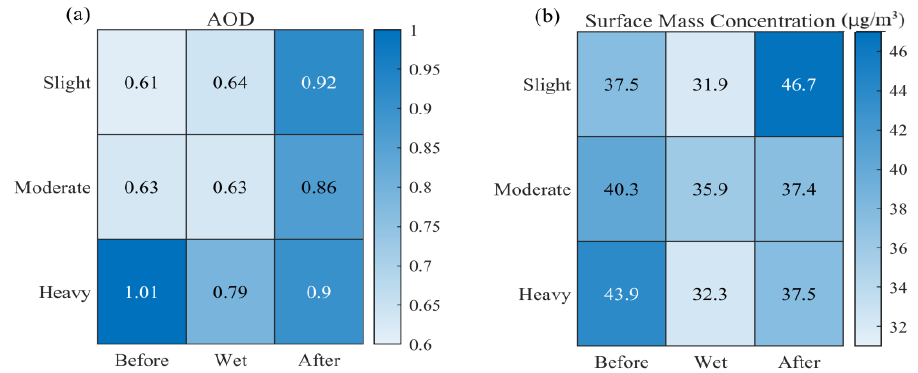
Figure 6. Daily average of ( a ) AOD; ( b ) surface mass concentration under different stages and lev-